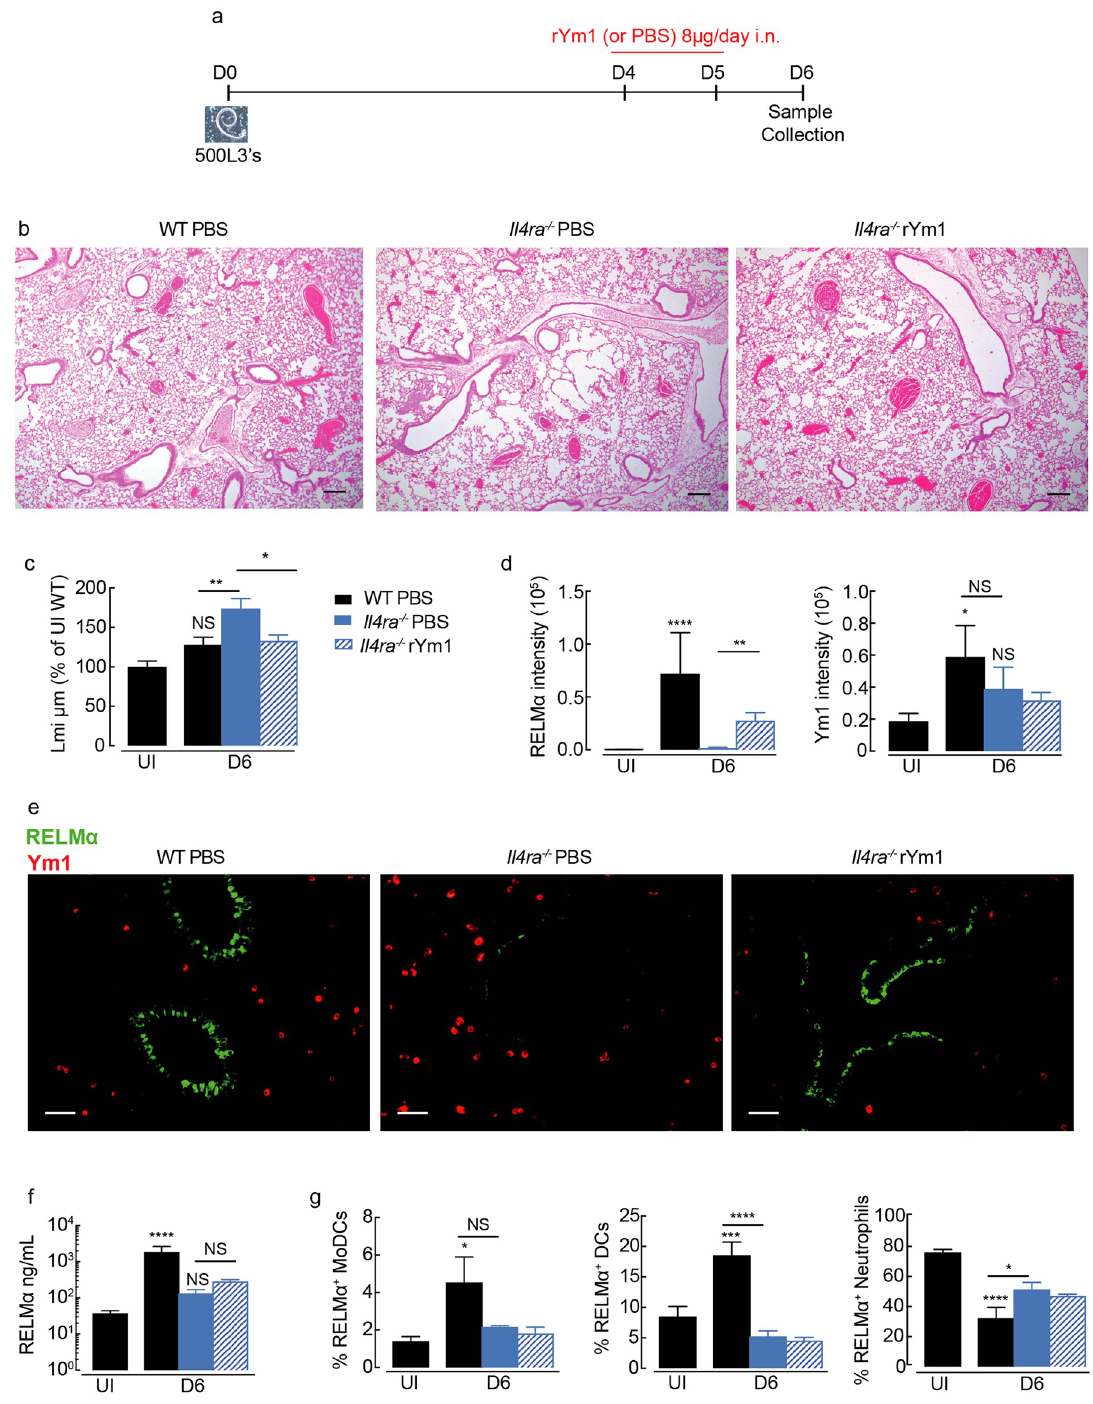
Fig 6. Ym1 regulates tissue repair and RELM α independently of IL-4R α . (a) Time-line of infection with N . brasiliensis and dosing with rYm1 (8 μ g) or PBS. ( b ) Microscopy of lung sections from N . brasiliensis infected (250L3, s.c.) wild-type C57BL/6 or IL-4R α -/- C57BL/6 mice (day 0) treated intranasally with recombinant Ym1 (8 μ g) or PBS (days 4 and 5) at day 6 post-infection, and stained with hematoxylin and eosin (images are representative of n = 5–6, scale bars, 200 μ m. ( c ) Quantification of lung damage as linear means intercept (Lmi), data normalised to average Lmi in uninfected wild-type PBS treated mice as in b , n = 6 per group; data are shown as mean ± sem; one-way ANOVA with Sidak multi-comparison test; NS not significant, � P < 0.05 and �� P < 0.01 compared to UI PBS treated mice. ( d ) Quantification of the fluorescent intensity of RELM α and Ym1 in lung sections in e stained from mice as in b ( n = 6 per